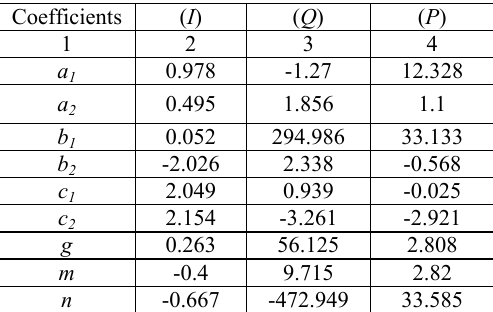
Table 2. Regression coefficients